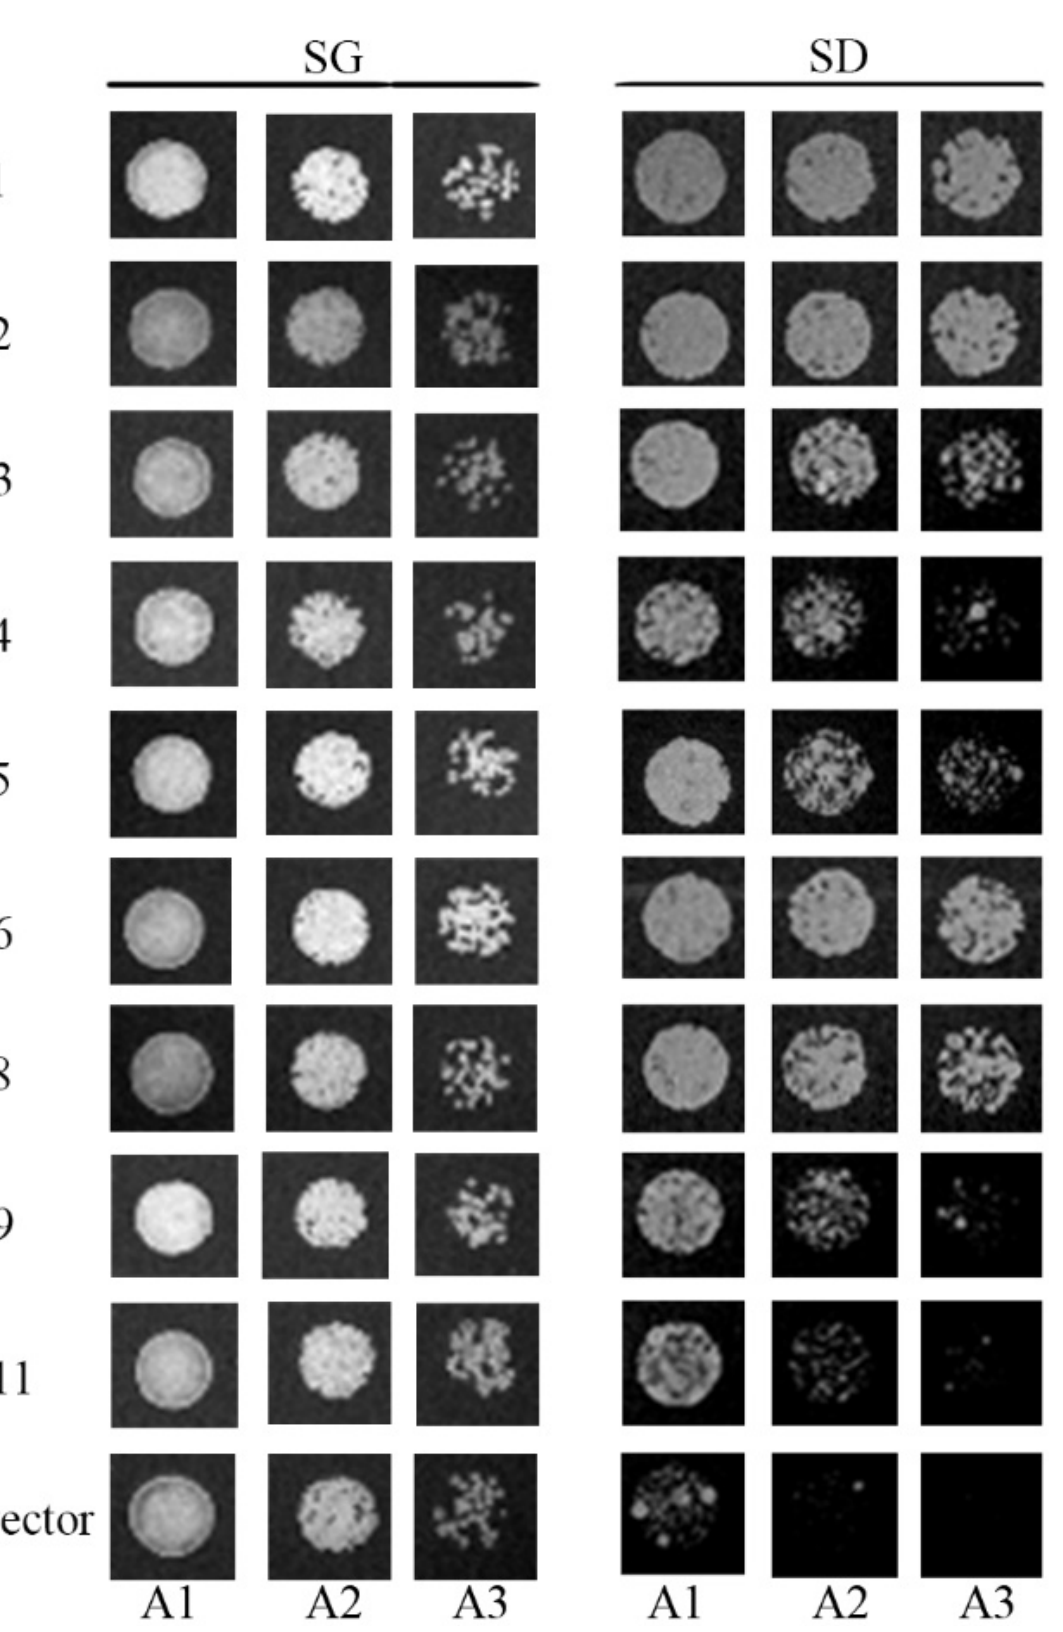
Figure 6. Functional expression of nine SbPht1 genes in yeast in the presence of sufficient P. The concentrations of A1, A2, and A3 were diluted 10, 100, 1000 times, respectively.